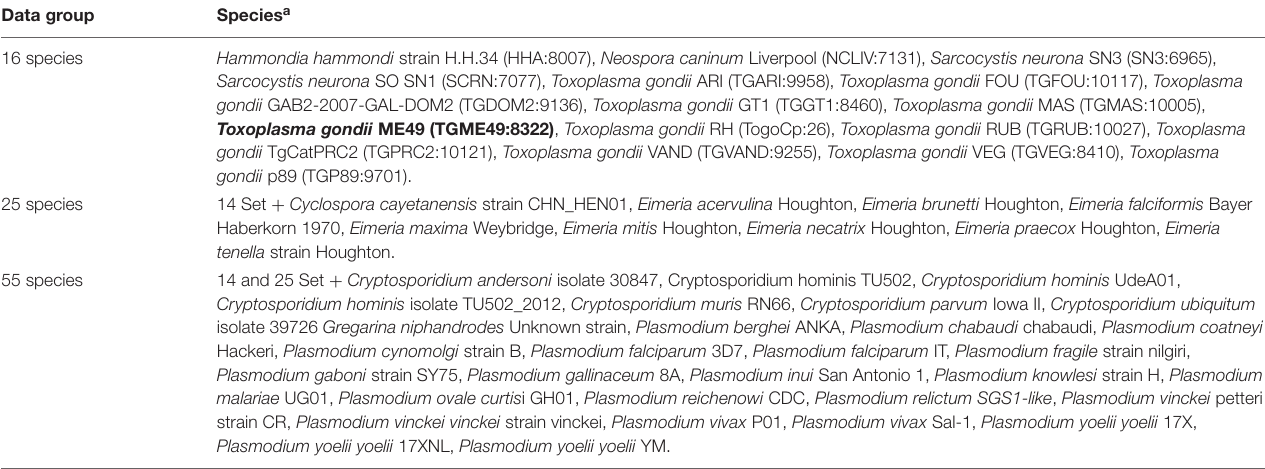
TABLE 1 | List of Apicomplexan species used in study.